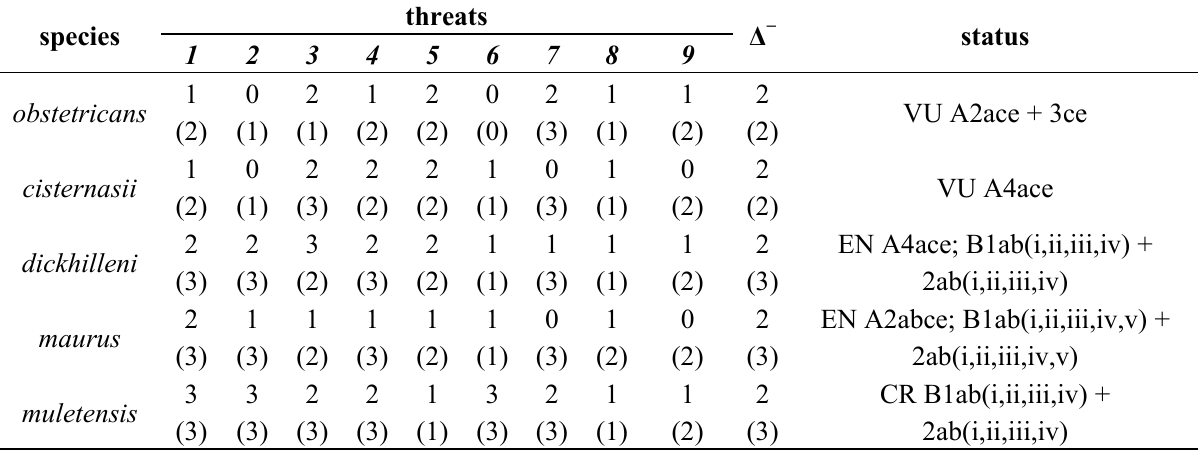
Table 1. Threats, declines within last decade and updated conservation status with supporting IUCN criteria for the five extant alytines. Threats are range fragmentation (1), total population size (2), habitat destruction (3), water extraction (4), landscape change (5), introduced predators (6), chytridiomycosis (7), diffuse pollution (8) and climate change (9). The severity of threats and declines is given as a rank, from 0 (not appreciable) to 3 (very important). Projections for the next decade are in